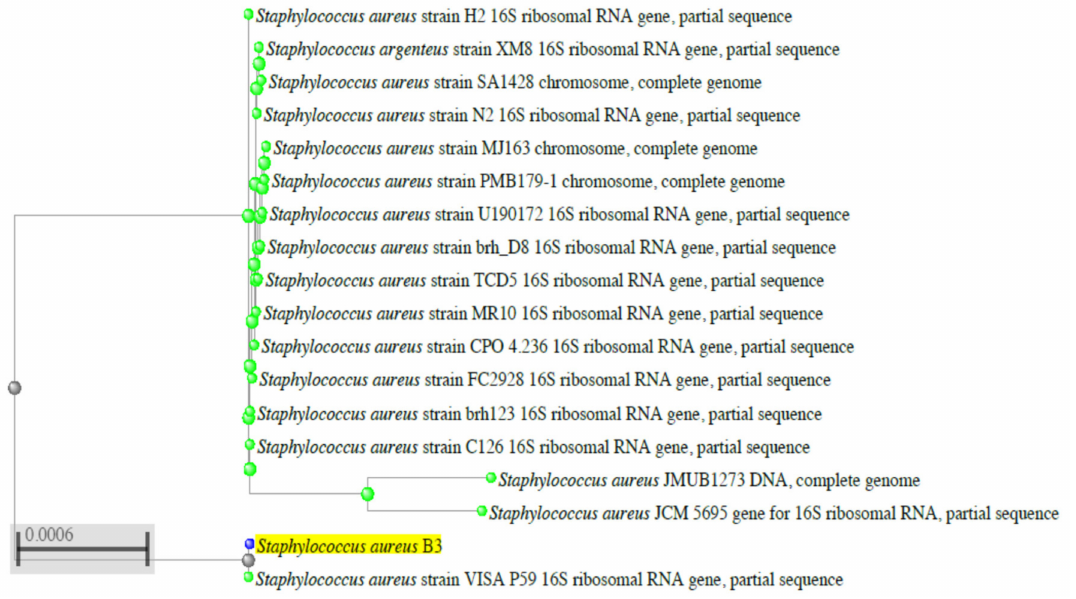
Figure 2. Cluster and dendrogram analysis showing the phylogenetic tree of S. aureus B3 with 99.5% similarity with a S. aureus